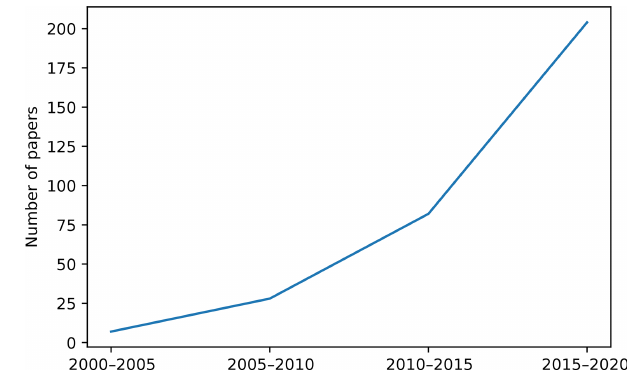
Figure 3. Distribution in time of the articles used in this